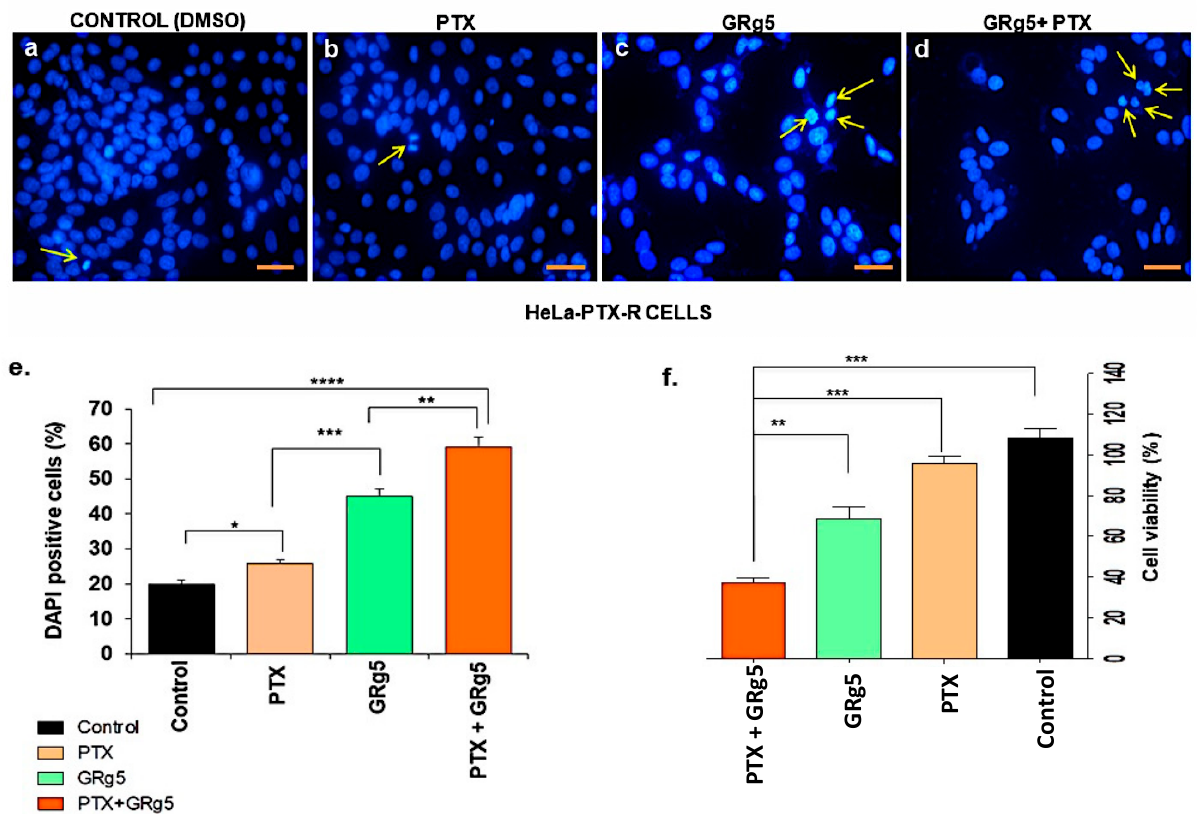
Figure 4. Detection of apoptosis by DAPI staining: Representative fluorescent photo micro-graphs showing apoptotic cells through DAPI staining of ( a ) control HeLa-PTX-R cells (DMSO), ( b ) cells treated with PTX alone, ( c ) cells treated with GRg5 alone, and ( d ) cells treated with PTX+GRg5. Histogram of quantitative analysis of ( e ) apoptotic cells (brightly fluorescent indicated with yellow arrow), and ( f ) the rate of cell viability. Three independent experiments were conducted. Data is represented as mean ± S.E.M of three individual observations. Statistical significance was assessed using One way-ANOVA and Tukey’s post hoc test. ****, p < 0.0001; ***, p < 0.001; **, p < 0.01; *, p ≤ 0.05. Scale bar = 100 μ m.